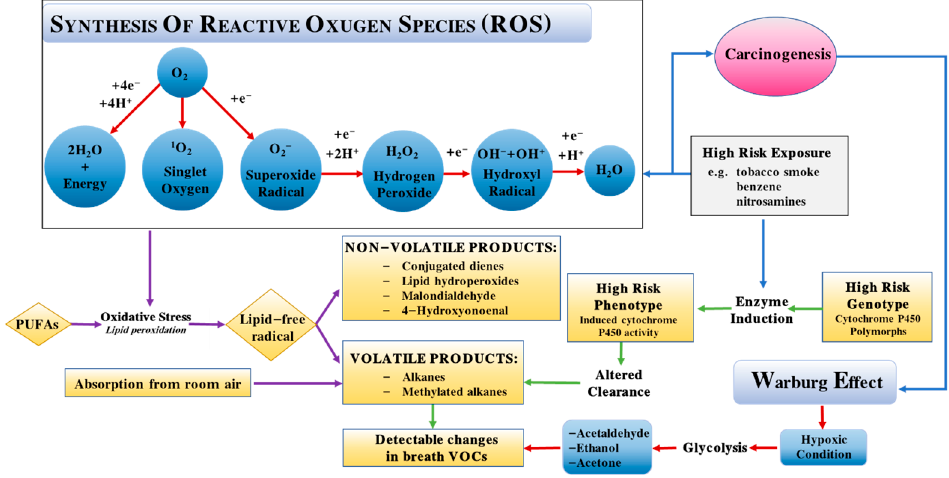
Figure 2. Hypothetical basis of the breath test for lung cancer. Lung cancer may result from the interaction of hereditary and environmental factors. Several cytochrome P450 mixed oxidases are activated by exposure to environmental toxins such as tobacco smoke. The induced phenotype may increase the risk of lung cancer by increased conversion of precursors to carcinogens. An altered pattern of cytochrome P450 mixed oxidase activity could modulate the catabolism of endogenous VOCs products of oxidative stress and generate an altered pattern of breath VOCs. The Warburg effect is another possible source of VOCs in the exhaled breath associated with glycolysis in a hypoxic condition.